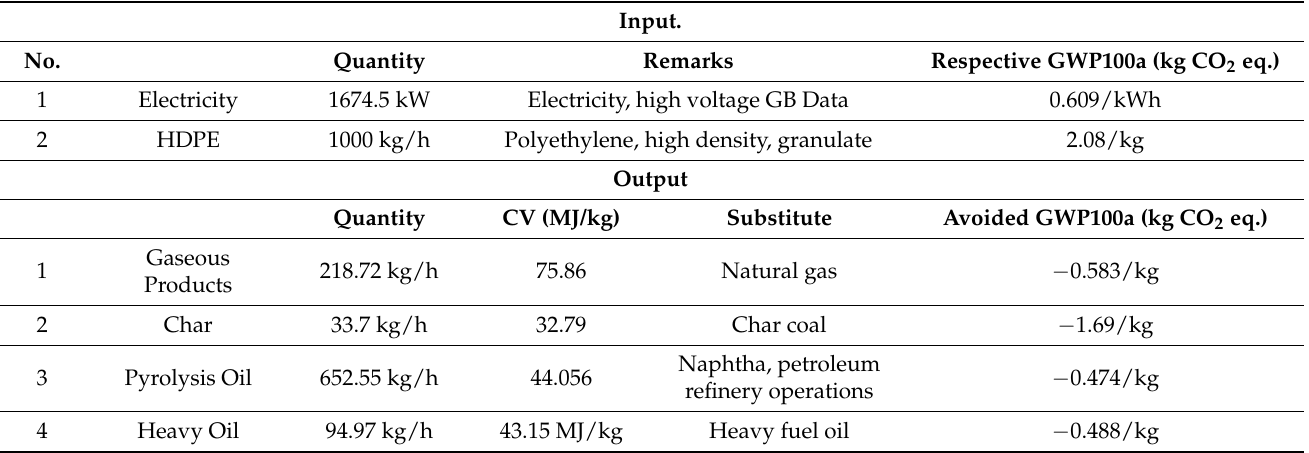
Table 13. Inventory data for the pyrolysis process per functional unit based on the simulation results. Input.